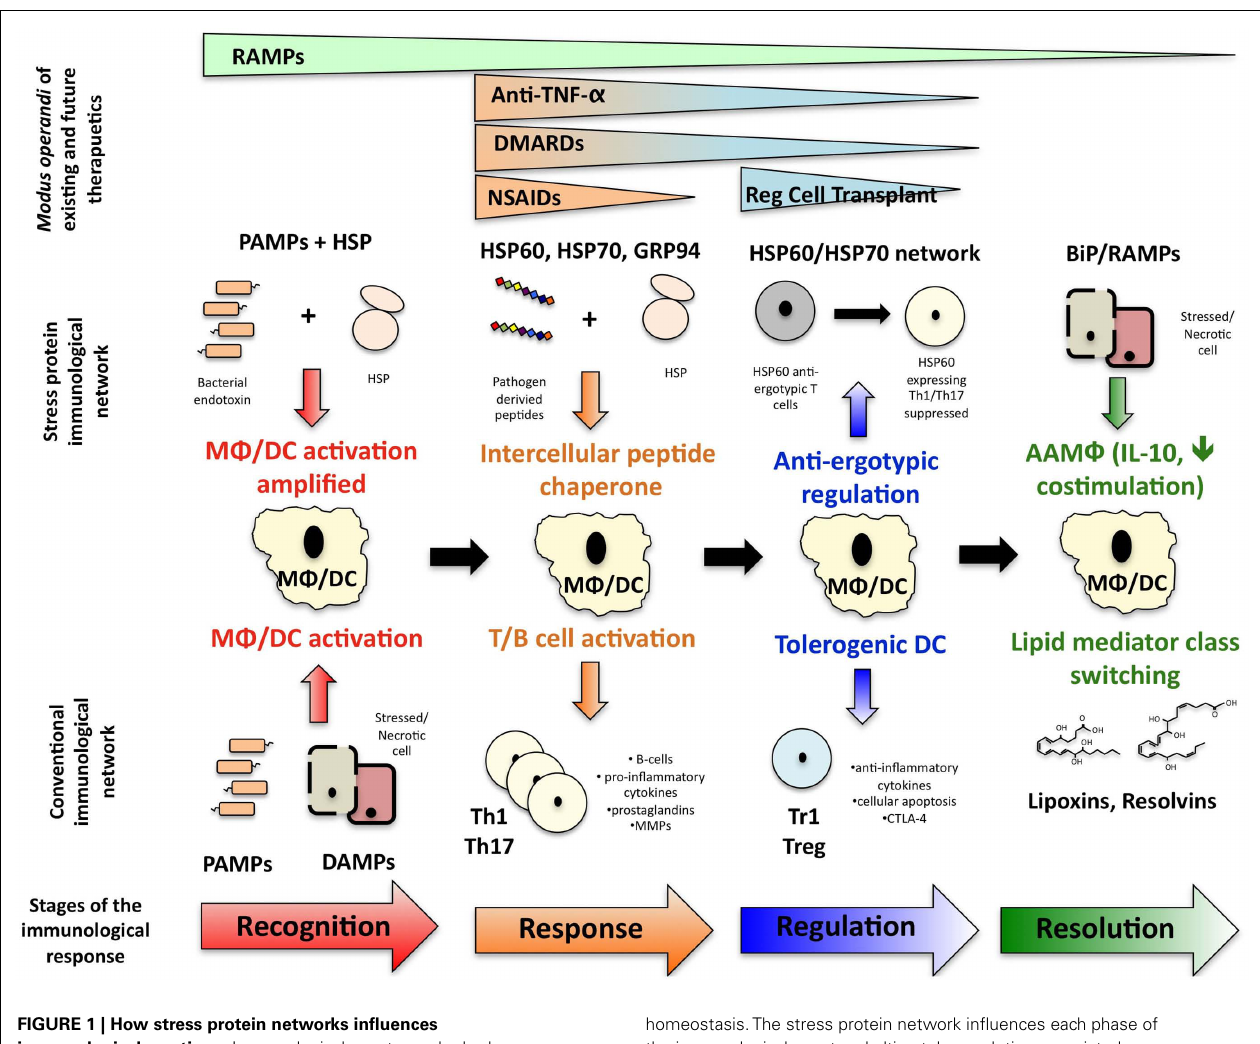
FIGURE 1 | How stress proteinnetworks influences immunological reactions. Immunological events can be broken down into a series of interdependent phases: immunological recognition, an immunological response following by regulation of that response and resolution of inflammation leading to a return to